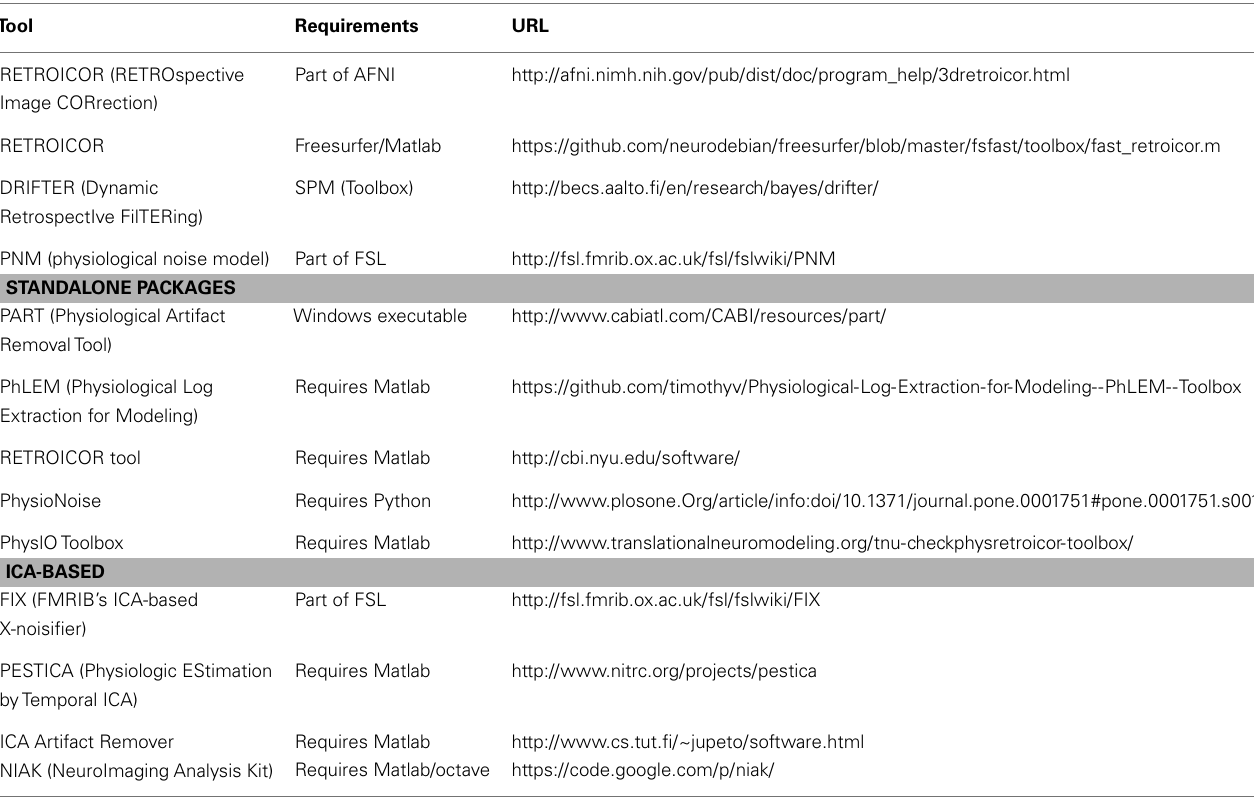
Table 1 | Summary of available physiological noise correction/removal